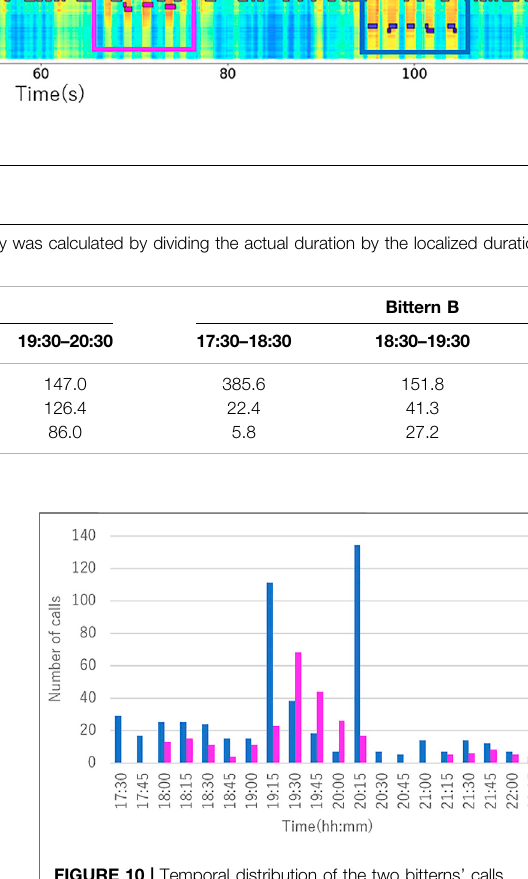
Figure 8 . At 18:30 on May 13th, Bittern A and B were localized at 45 ° and 350 ° , respectively, with respect to the microphone array.